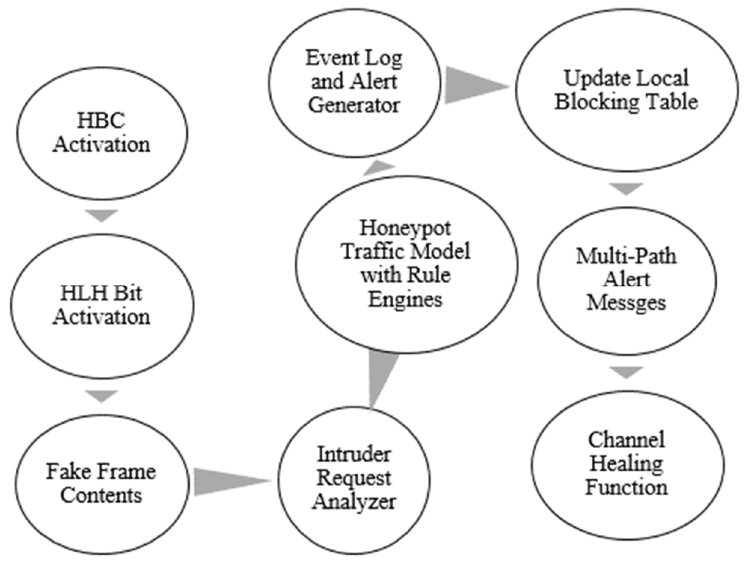
Figure 6. HBC and IVB.